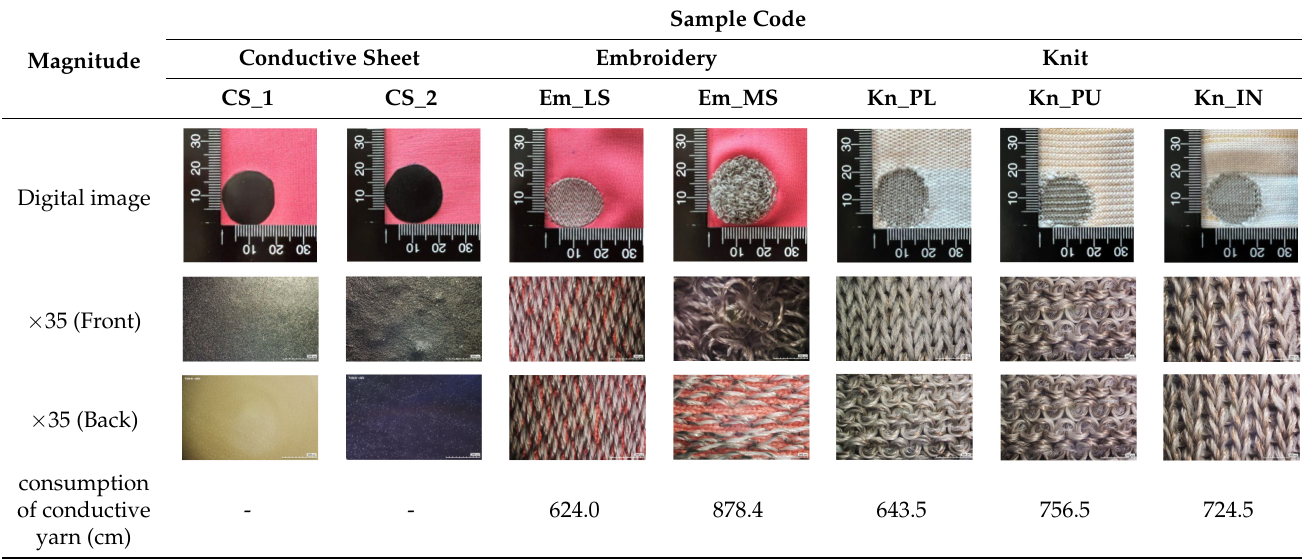
Table 2. Morphology and consumption of conductive yarn of the textile-based dry electrode. Sample Code Conductive Sheet Magnitude